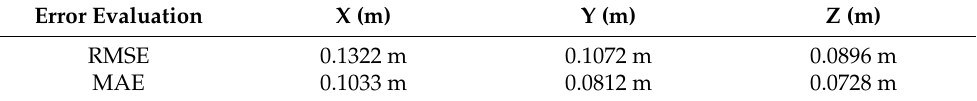
Table 5. Calculated RSME and mean absolute error (MAE) of the dynamic object position estima- tion.